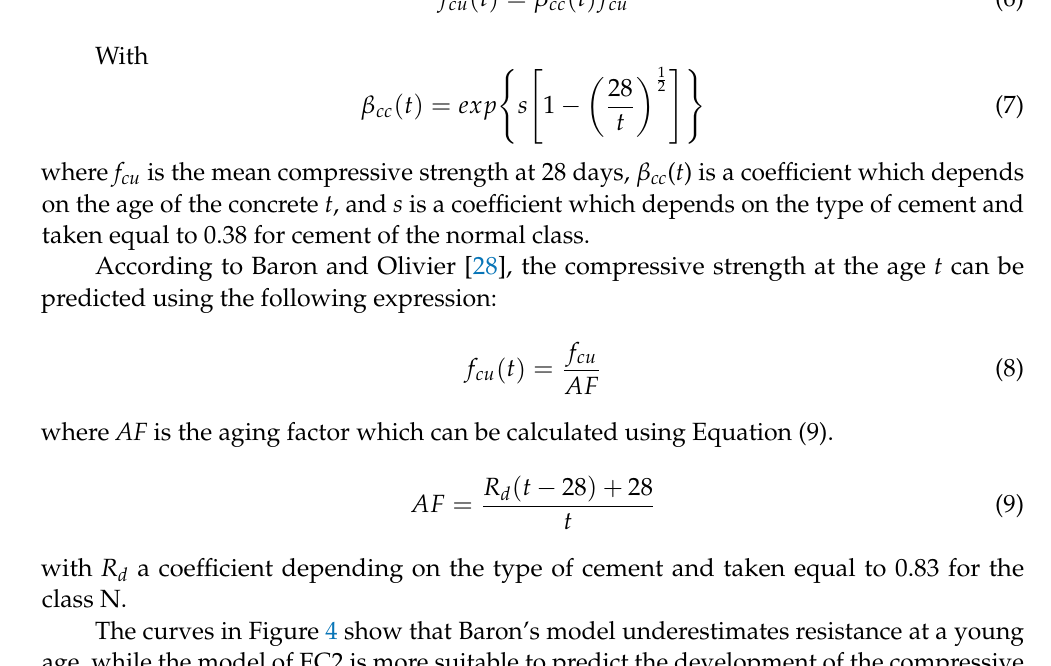
Figure 4. Development of the compressive strength over time, ( a ) RCC0, ( b ) RCC50, ( c ) RCC70, ( d ) RCC100.